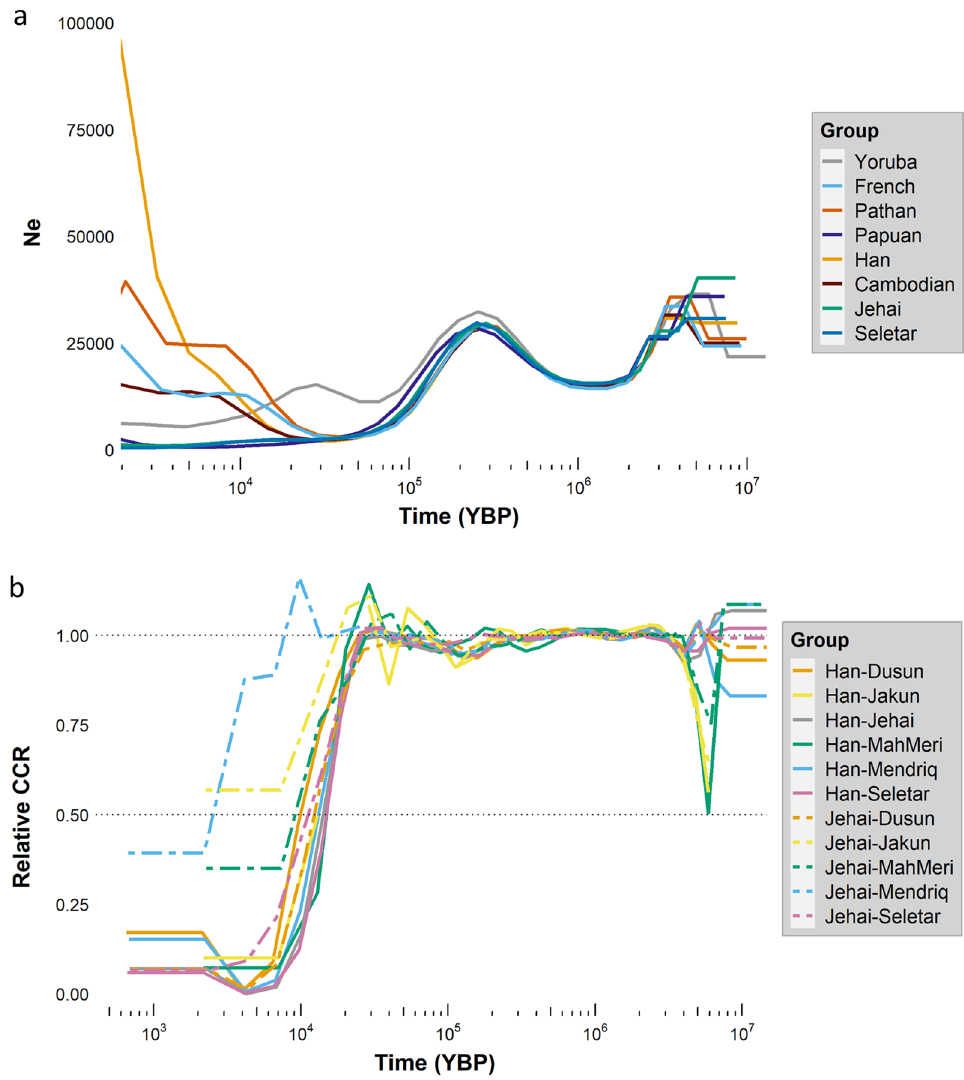
Figure 2. Inference of effective population size (Ne) and population divergence using MSMC2. ( a ) Inference of Ne in Jehai, Seletar and selected HGDP populations using eight haplotypes per population. Pattern of Ne through time in Jehai and Seletar is consistent with Out-of-Africa human migration, however both tribes retained a low Ne after the bottleneck 70–50 KYBP. ( b ) Estimation of divergence time between indigenous Malaysian and Han using four randomly selected haplotypes per population (in case of Mah Meri and Jakun limited to two haplotypes). A relative cross coalescence rate (CCR) around 0.5 heurostically can be used as a split time between the two populations. Plots are generated using ggplot2 version 3.3.3 package (https:// ggplo t2. tidyv erse. org/) in R version 4.0.4 (https:// www.R- proje ct.